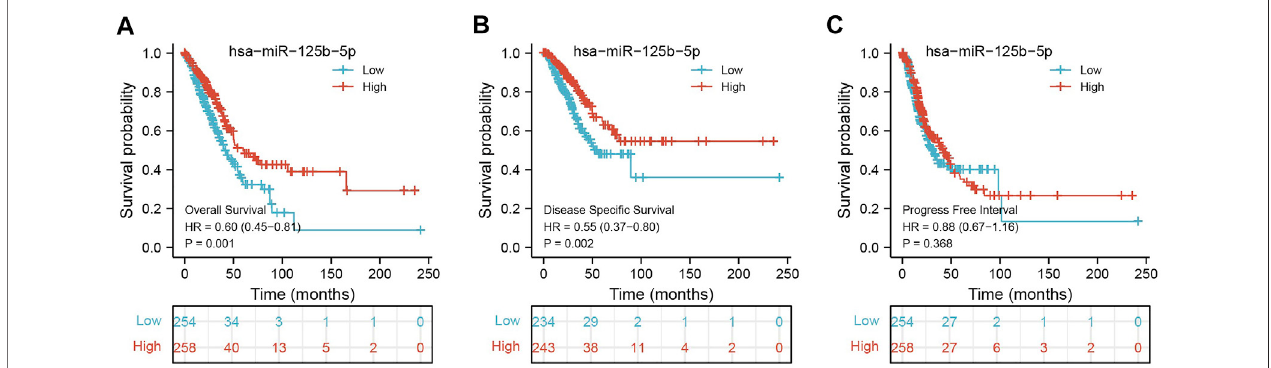
FIGURE 5 | Prognostic value of miR-125b-5p in lung adenocarcinoma (LUAD). Prognostic value of miR-125b-5p in LUAD, including overall survival (A) , disease- speci fi c survival (B) , and progression-free interval (C) .